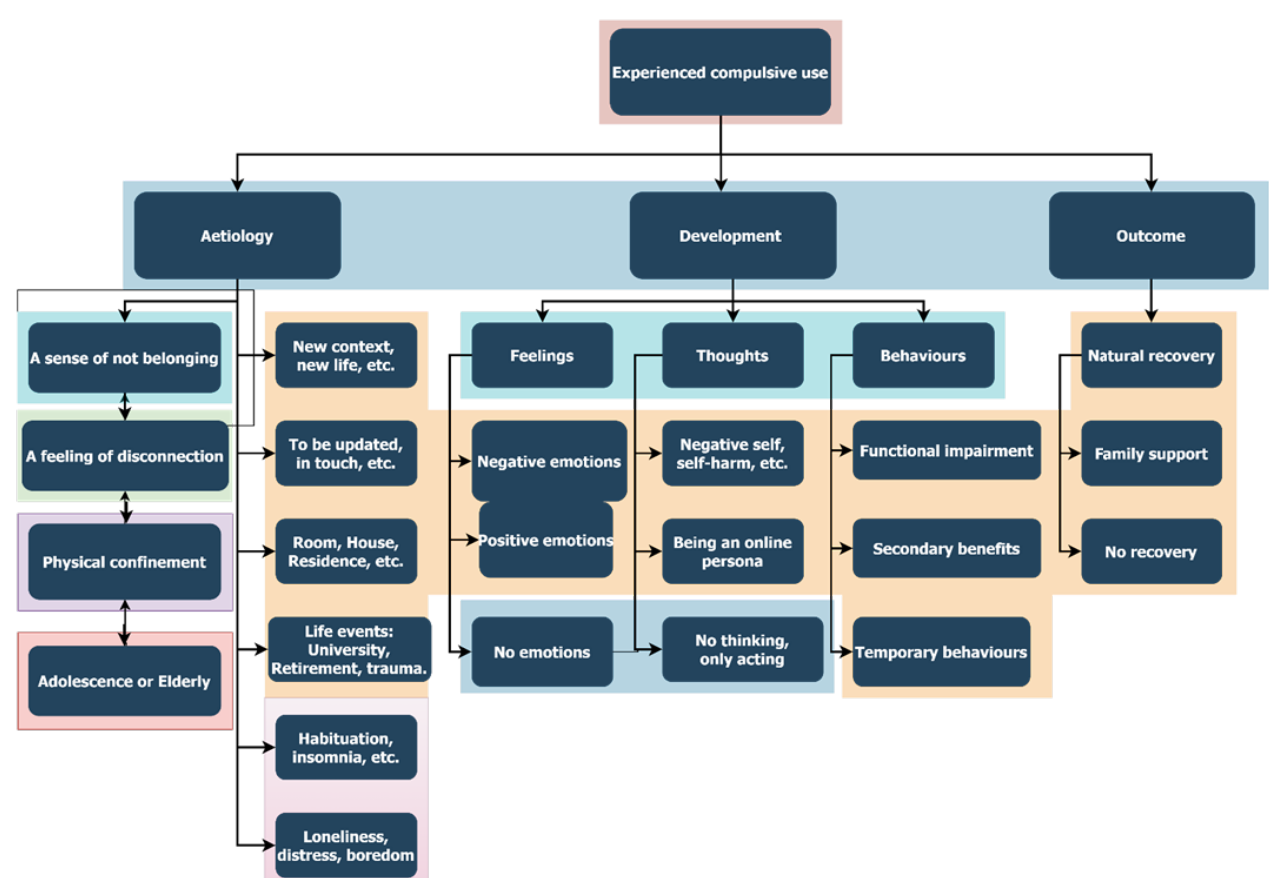
Figure 2. Themes and subthemes of the qualitative analysis. Theme 1: Aetiology of Compulsive Internet Use